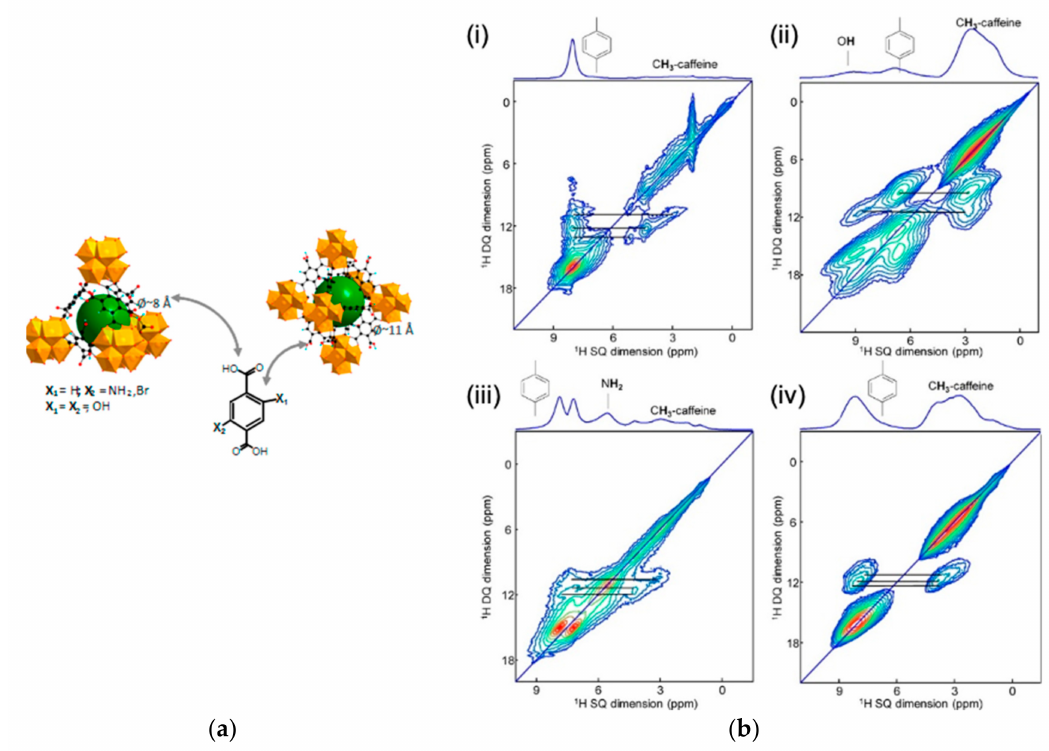
Figure 5. ( a ) Schematic view of the tetrahedral (left) and octahedral (center) cages of the dehydrated UiO-66(Zr). Zirconium polyhedra and carbon atoms are in orange and black, respectively. Hydrogen atoms are omitted for clarity. ( b ) 1 H- 1 H DQ-SQ MAS NMR experiments on different functionalized UiO-66(Zr) samples (-H ( i ), -NH 2 ( ii ), -2OH ( iii ), -Br ( iv )) loaded with caffeine. The lines indicate the correlation between the protons of the linker of the MOF and the ones of the CH 3 group of the caffeine [21].